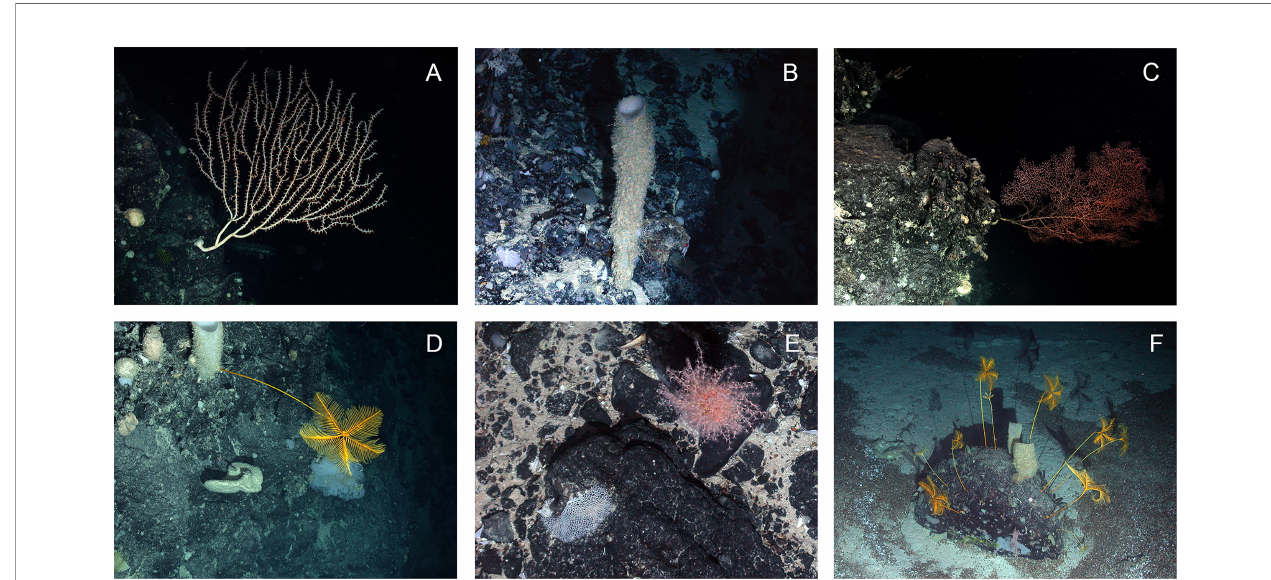
FIGURE 10 | Examples of species associated with rocky substratum on the northern Mid-Atlantic Ridge. Dive number indicated with D in caption. (A) Isididae sp. on steep rock wall D173; (B) Sponge on rock wall D159; (C) Chrysogorgia sp. on steep rock wall D173; (D) Anachalypsicrinus nefertiti on rocky wall D173; (E) Unknown octocoral on rock in mixed substratum area D178; (F) soft sediment with pteropod thanatocoenoses and boulder with multiple crinoids ( Anachalypsicrinus nefertiti ) and sponges D178. Images collected on two dives during ECOMAR cruise JC048: Dive 173 (station 40, ECOMAR SW Site, Date 21 June 2010, 48° 44.118 N 28° 39.335 W, 2623-2428 m depth) and Dive 178 (station 53, ECOMAR SE Site, Date 27 June 2010, 49° 1.439 N 27° 41.264, 2442- 2630 m